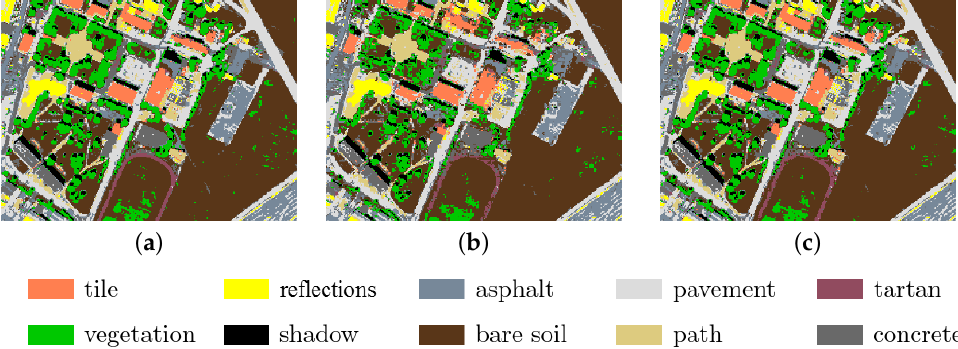
Figure 11. “Toulon” peri-urban dataset: land-cover-classification maps of fused and REF images.